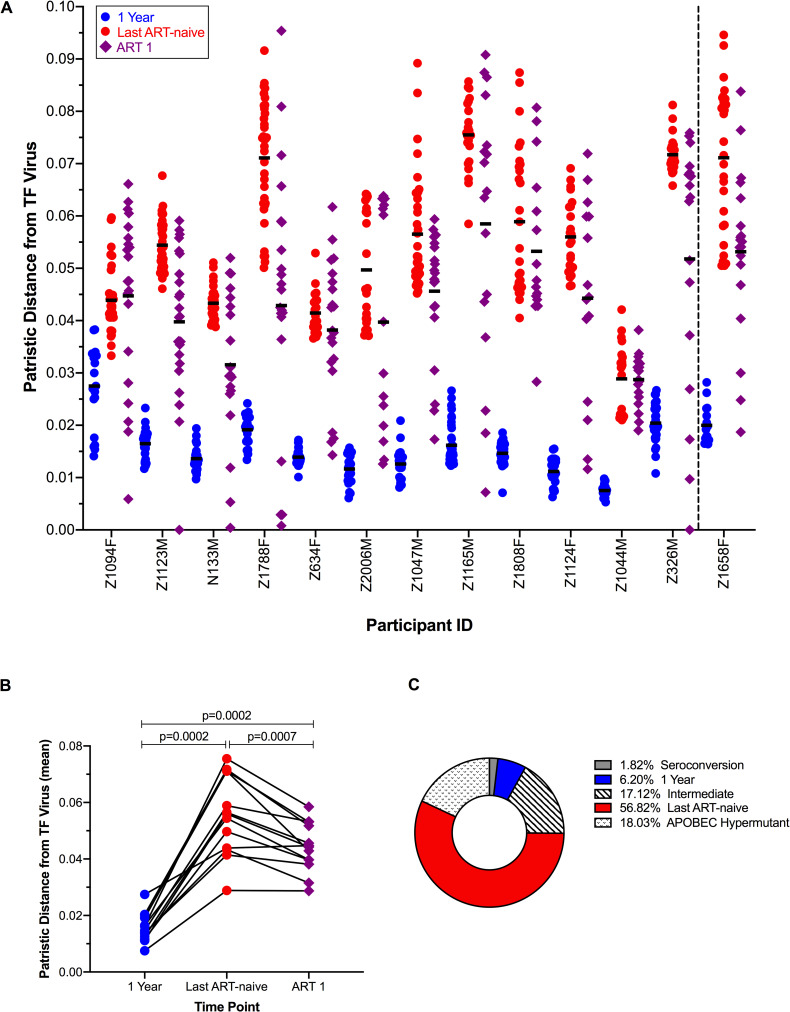
Divergence from transmitted/founder (TF) virus increases during ART-naïve infection and decreases on treatment.(A) Patristic distances from the TF virus, or root-to-tip values, from the maximum-likelihood (ML) trees are shown for all 13 participants, with the single instance of multivariant infection in participant Z1658F shown at the far right. Where two samples were assessed during treatment, only the first is shown here. Mean values are indicated by horizontal black bars. (B) Summary of the mean intrapatient patristic distances, where the mean distance is significantly different between each time point assessed (Wilcoxon matched-pairs signed rank tests). (C) Proportion of proviruses seeded into the reservoir, by era, as estimated from the placement of reservoir sequence in the phylogeny. The mean values of proportions for all 13 volunteers are shown, while proportions for each participant are given in S4 Fig. A majority of variants are most closely related to variants present at the last ART-naïve time point. The percentage of variants demonstrating APOBEC hypermutation is also indicated, though these sequences were excluded from analysis.